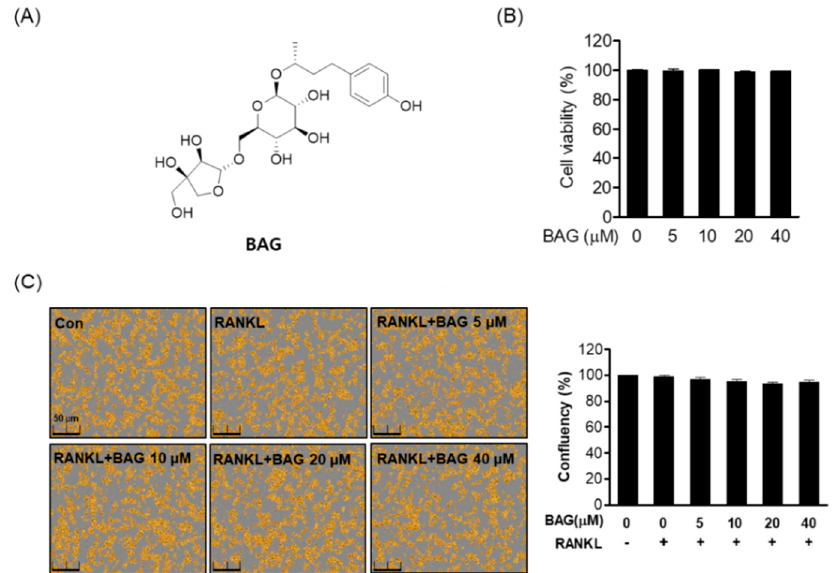
Figure 1. Effects of BAG on cytotoxicity and cell confluency in RAW264.7 cells. ( A ) The chemical structure and formula of BAG. ( B ) RAW264.7 cells (5 × 10 3 cell/mL) were seeded for 24 h and then treated with BAG at the indicated concentration (5–40 µ M) in 96-well plates for 5 days, and viability was measured by MTT assay. ( C ) The confluency (%) of RAW 264.7 cells was determined using the Incucyte ® Live-Cell analysis imaging system.